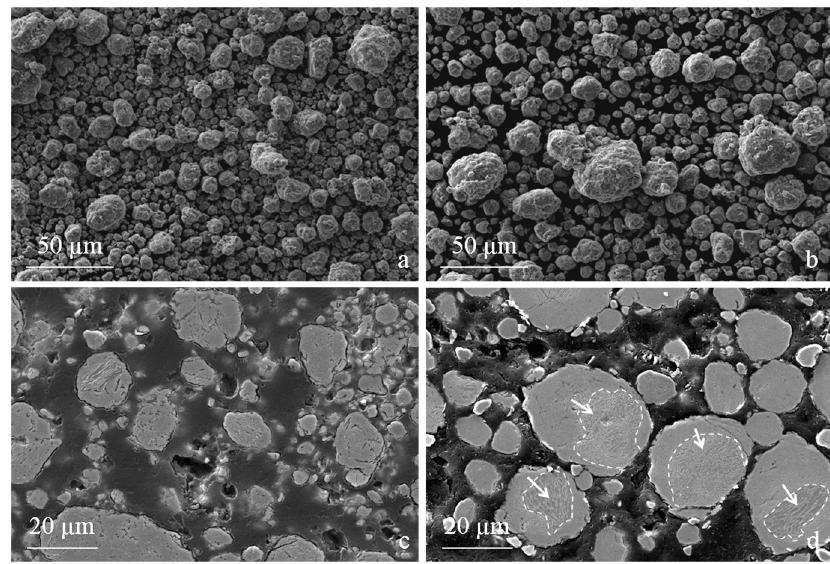
Figure 3. Microstructure (SEM) of the powders ( a ) AISI H13 and ( b ) AISI M3:2 milled for 500 cycles. Metallographic cross section of the same powders ( c ) AISI H13 and ( d ) AISI M3:2 at a greater magnification.